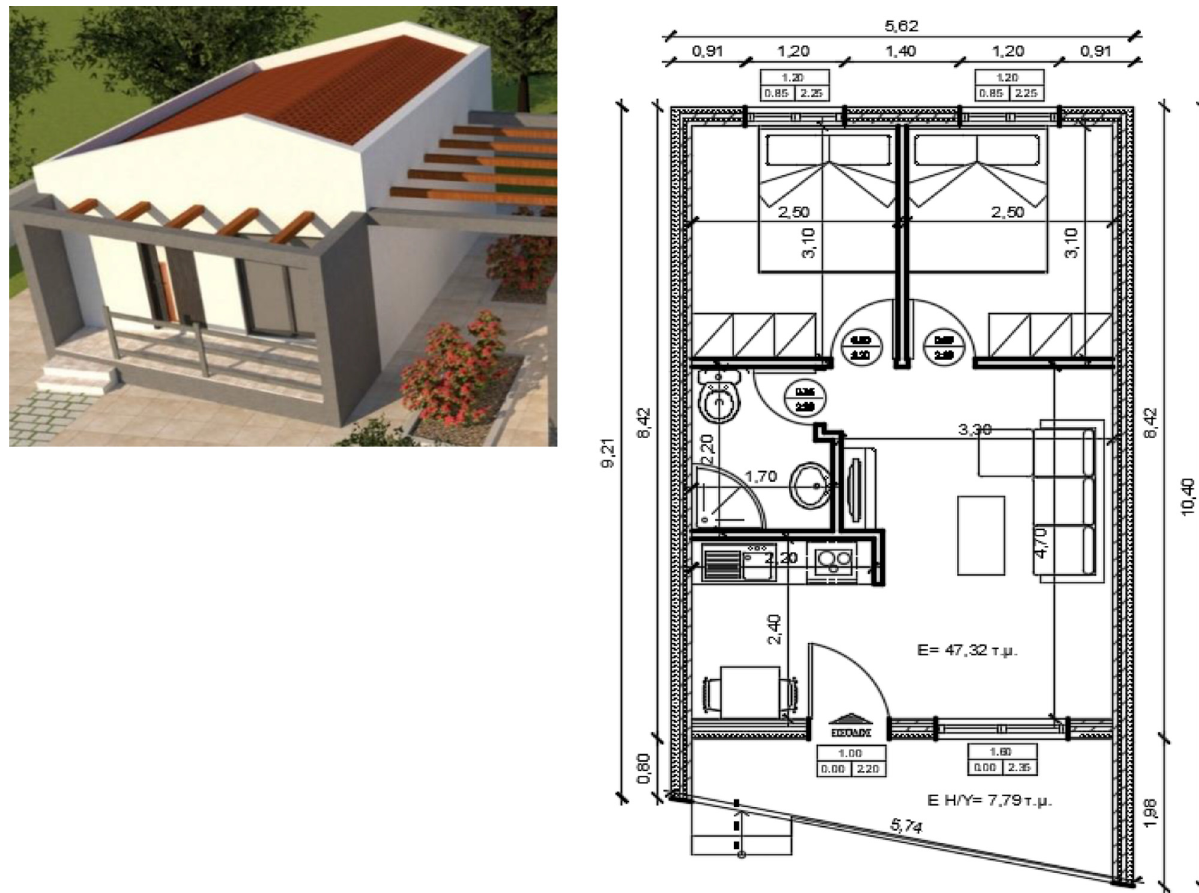
Fig. 1. External 3D view and plot of the examined